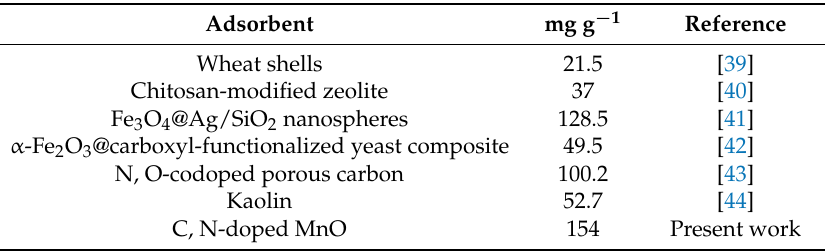
Table 3. Comparison of the adsorption capacities of different absorbents from previous reports with that of C, N-MnO-4.